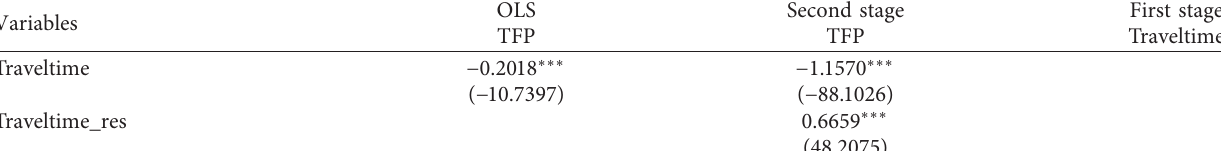
Table 9: Result of instrumental